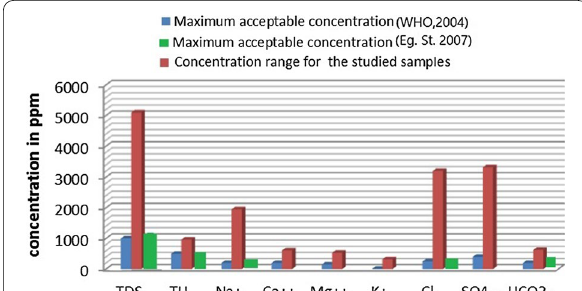
(Fig. 12). The representation of groundwater samples parameters on the Wilcox diagram indicates that almost all of the samples are located in C3-S1 and C3-S2 classes (low